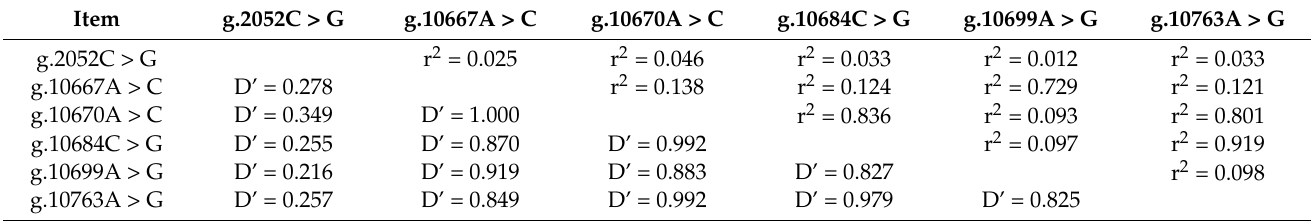
Table 4. Linkage equilibrium analysis between SNP markers in GHRHR .